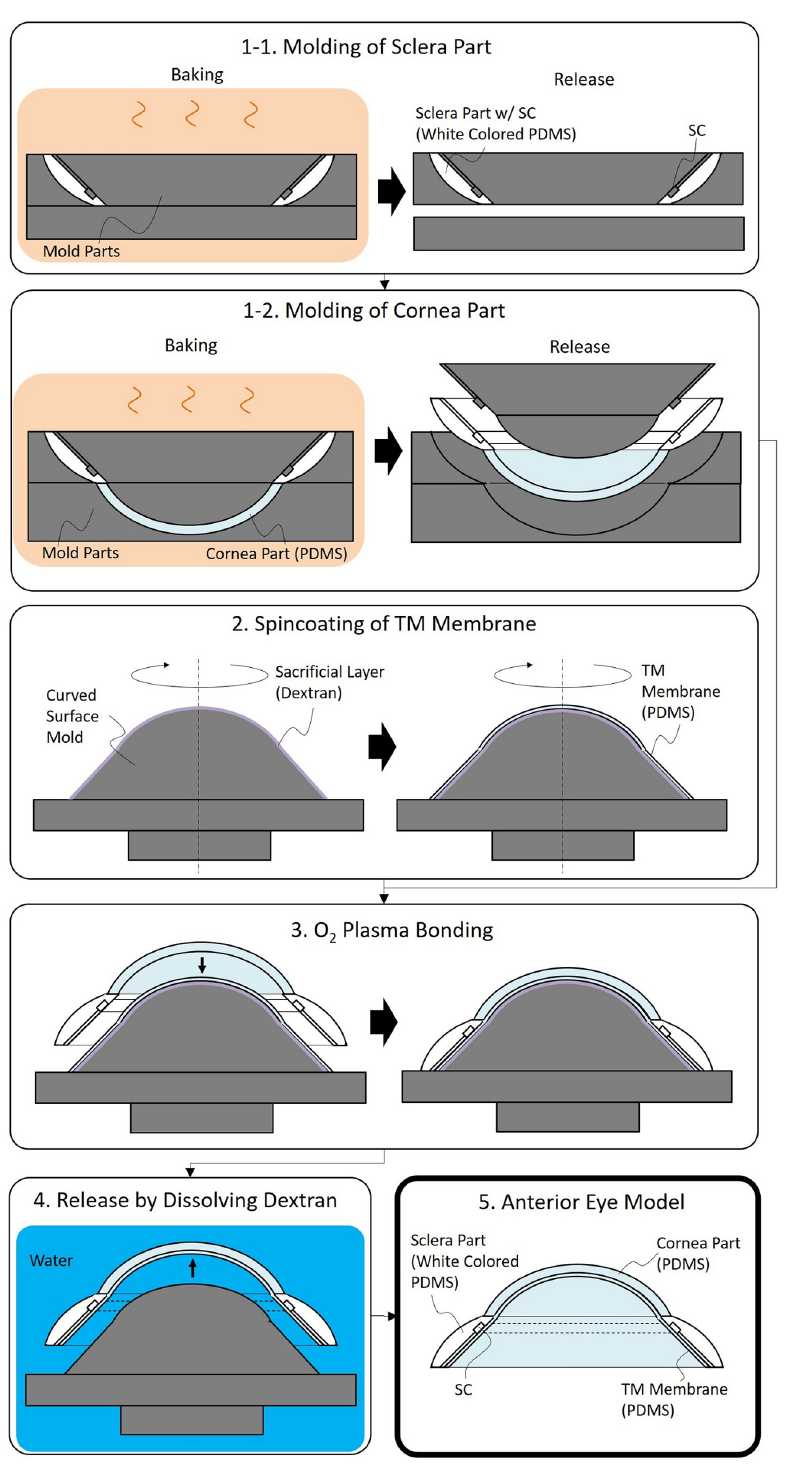
Fig 5. Fabrication process of the anterior eye model.